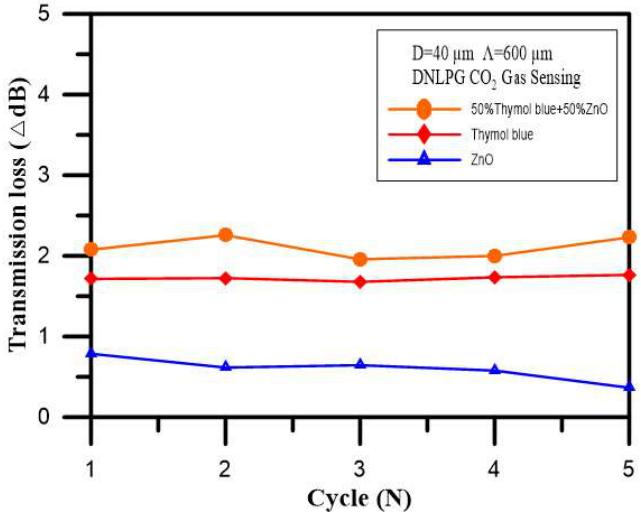
Figure 8. Changes in transmission loss for the CO 2 gas sensors with different sensing films.